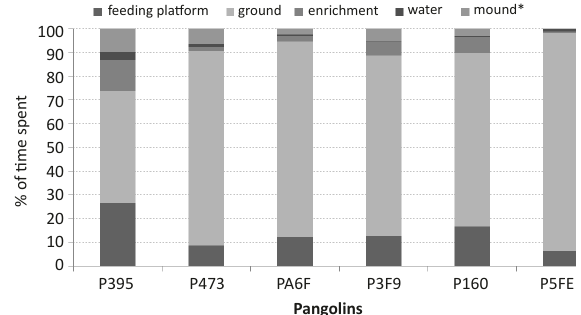
Figure 3. Mean time allocation in enclosure space utilisation by Indian Pangolins. Key: * Over mound activity refer to behaviour like walking over